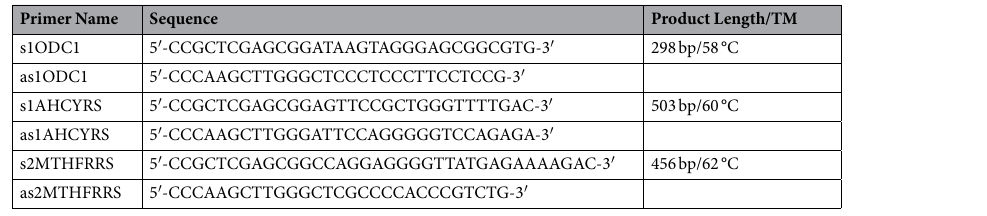
Table 4. Primers used for luciferase reporter